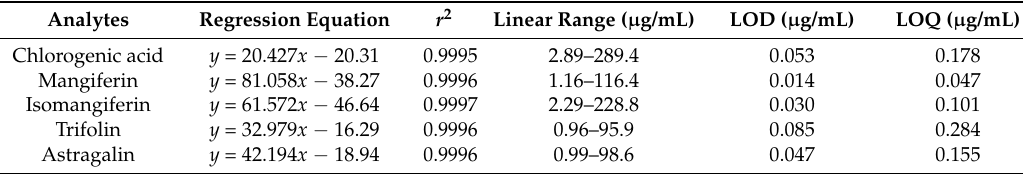
Table 1. Linear relation between peak area and concentration.